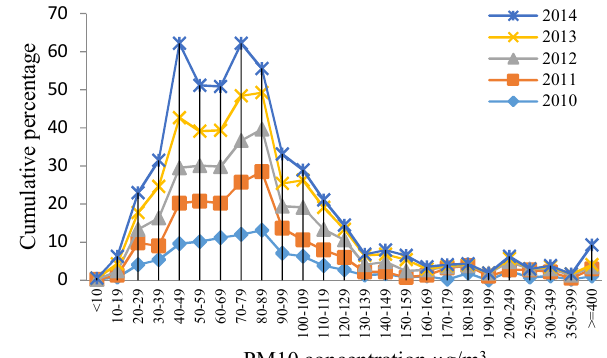
Fig. 3. Cumulative percentage of days in which people were exposed to different concentrations of PM